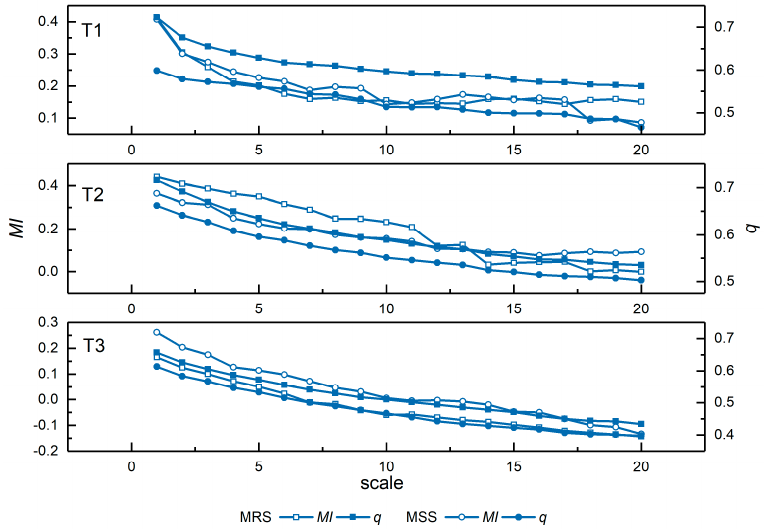
Figure 8. Changes in q and MI from the segmentation results of T1, T2 and T3 using MRS and MSS at Figure 8. Changes in (cid:1869) and (cid:1839)(cid:1835) from the segmentation results of T1, T2 and T3 using MRS and MSS at scales 1 to 20. scales 1 to 20. Figure 8. Changes in (cid:1869) and (cid:1839)(cid:1835) from the segmentation results of T1, T2 and T3 using MRS and MSS at scales 1 to 20.